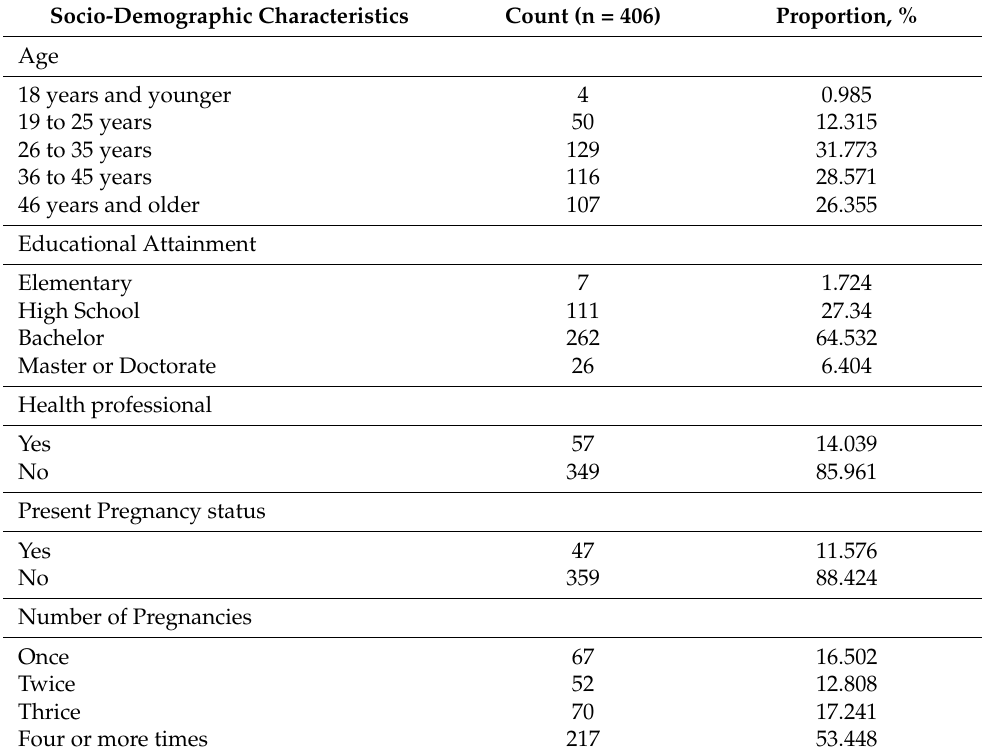
Table 1. Socio-demographic profile of the